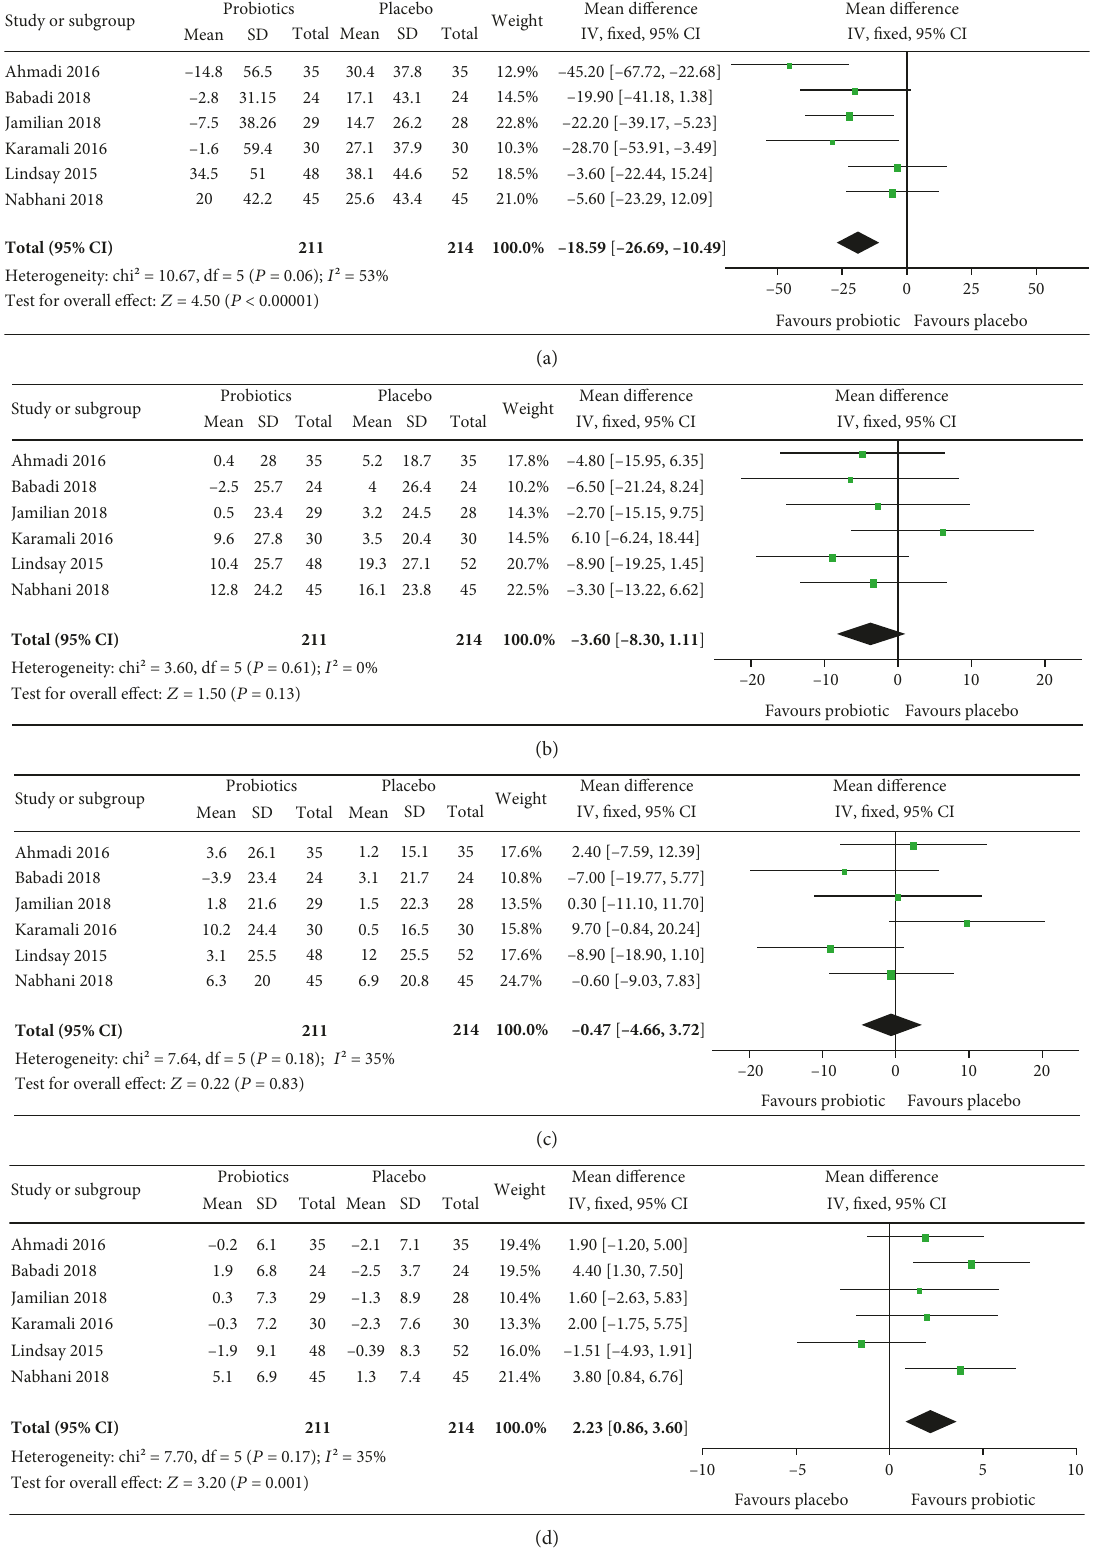
Figure 5: E ff ect of probiotic supplementation on blood lipid pro fi les: (a) triglycerides (mg/dL), (b) total cholesterol (mg/dL), (c) LDL- cholesterol (mg/dl), and (d) HDL-cholesterol (mg/dL) in pregnant women with gestational